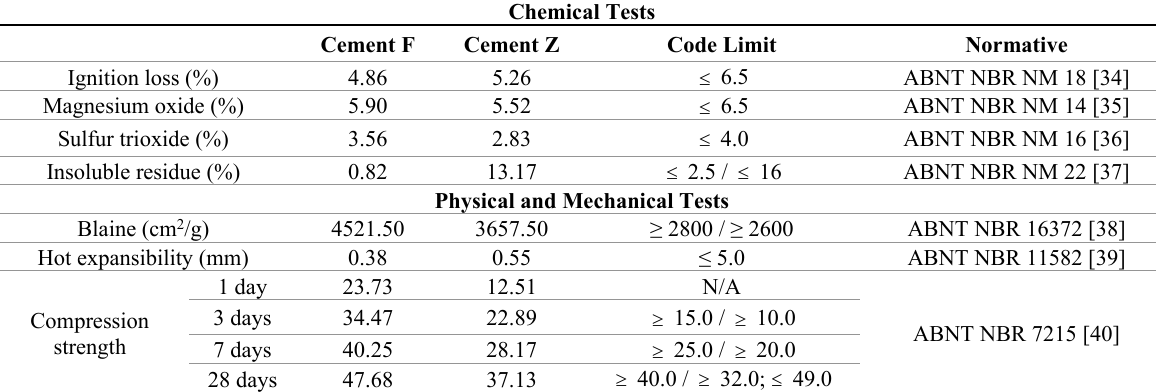
Table 2. Chemical, physical, and mechanical characteristics of cements CPII F-40 and CP II